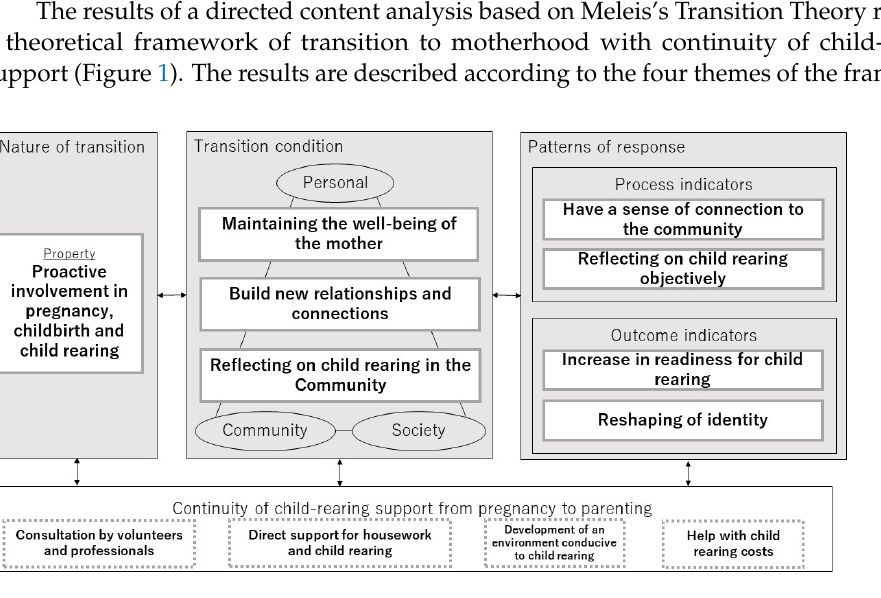
Figure 1. Theoretical framework of the transition to motherhood with child-rearing support contin-